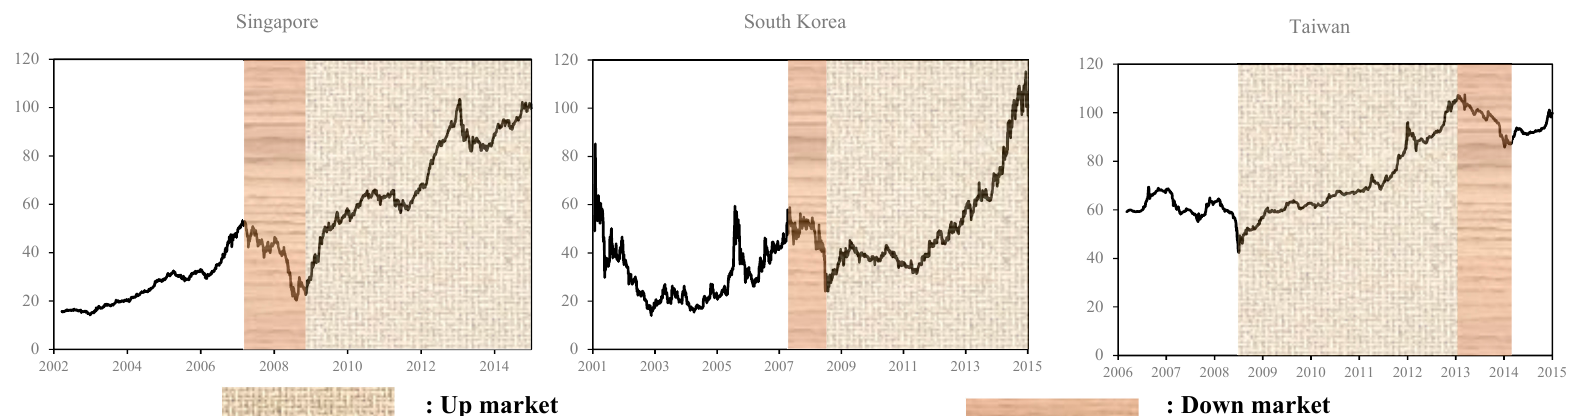
: Up market : Down market Figure 3. Definition of up- and down-markets. The value-weighted price indices are calculated by using Equation (2). The base period (index = 100) is 30 April 2015 for all markets.